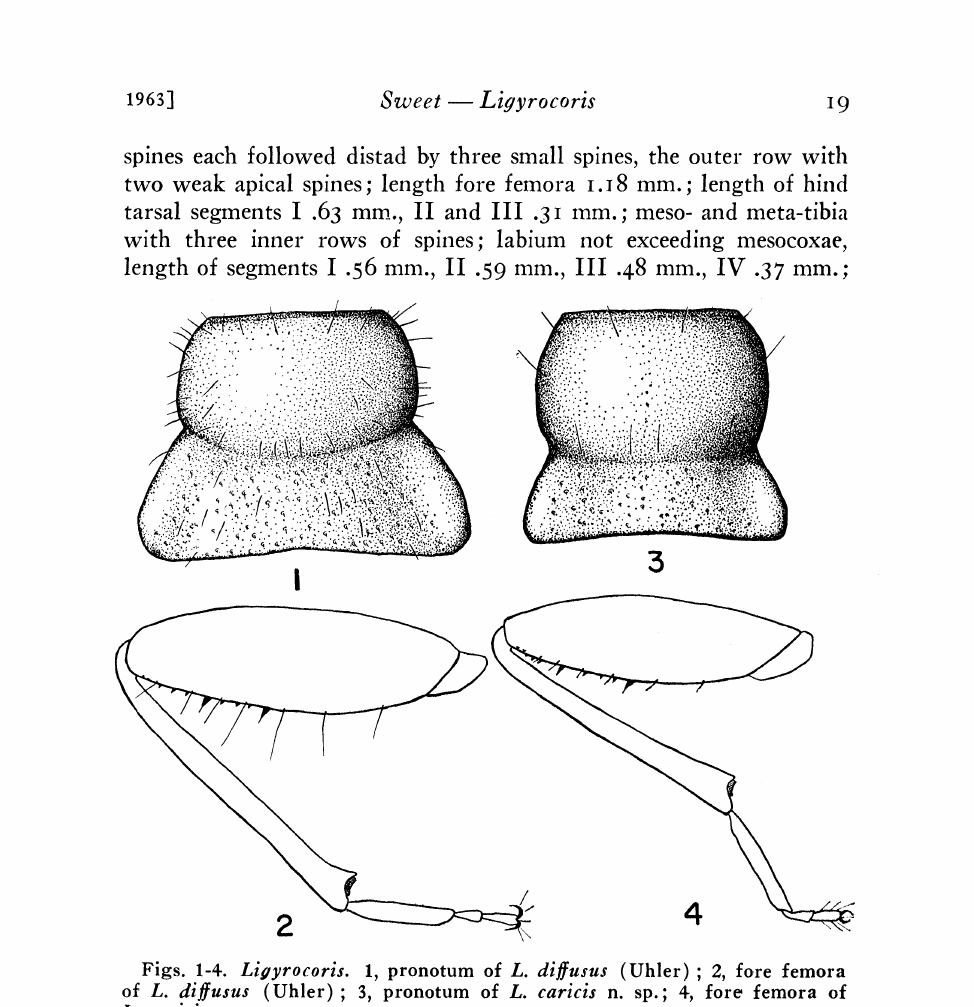
Figs. 1-4. Ligyrocoris. 1, pronotum of L. diffusus (Uhler) 2, fore femora of L. diffusus (Uhler) 3, pronotum of L. caricis n. sp.; 4; fore femora of L. caricis n. sp. antennae relatively long, length of segments I .56 mm., II .94